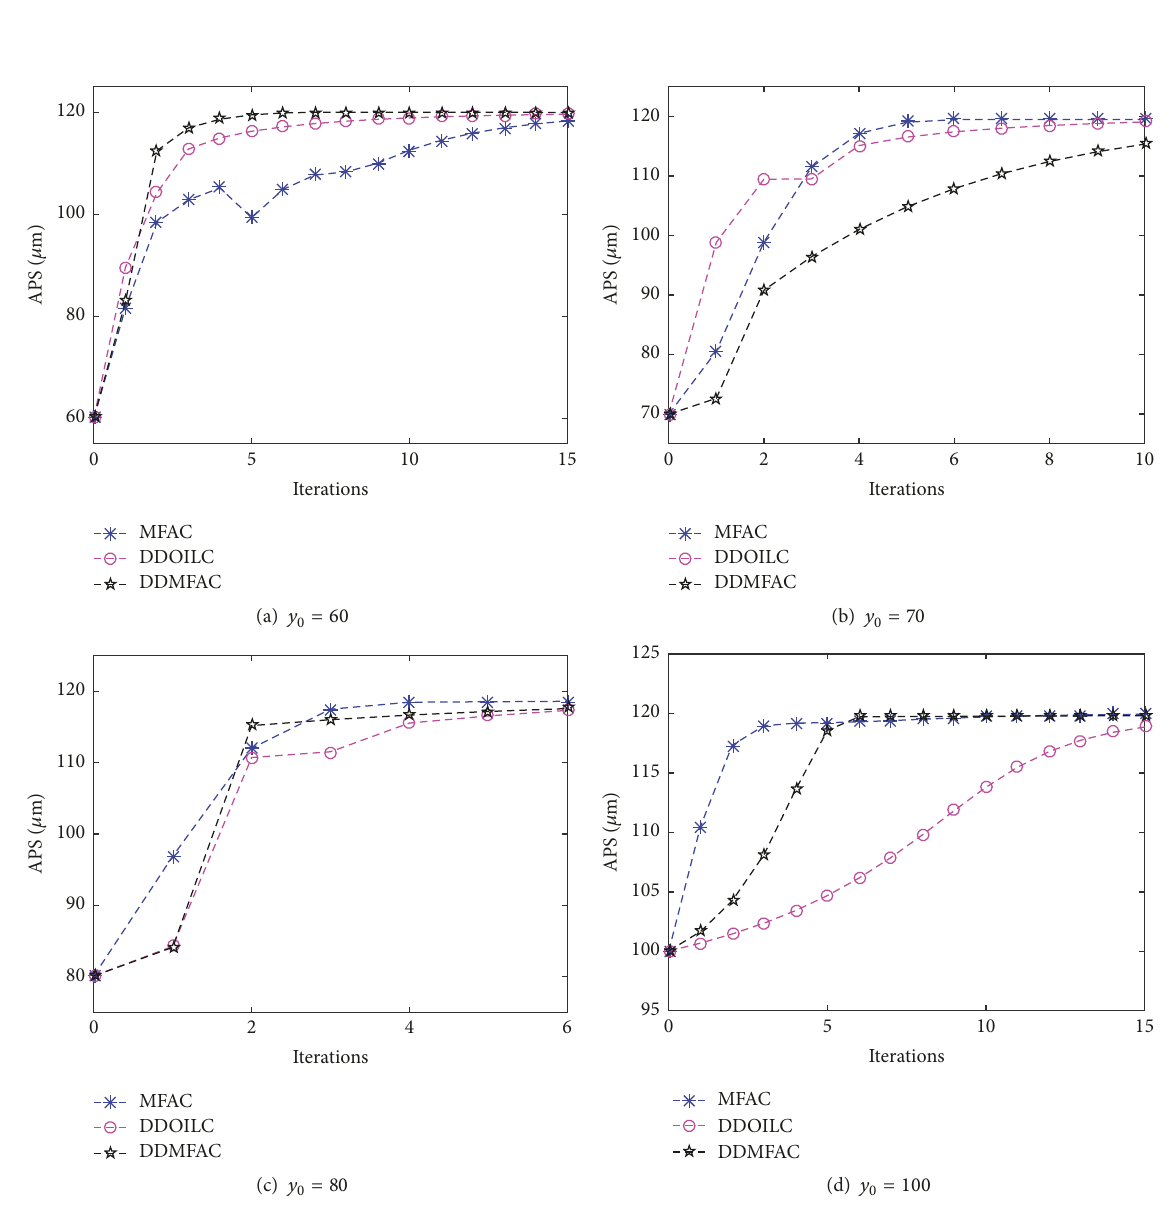
Figure 5: The comparison of control effects of MFAC, DDOILC, and